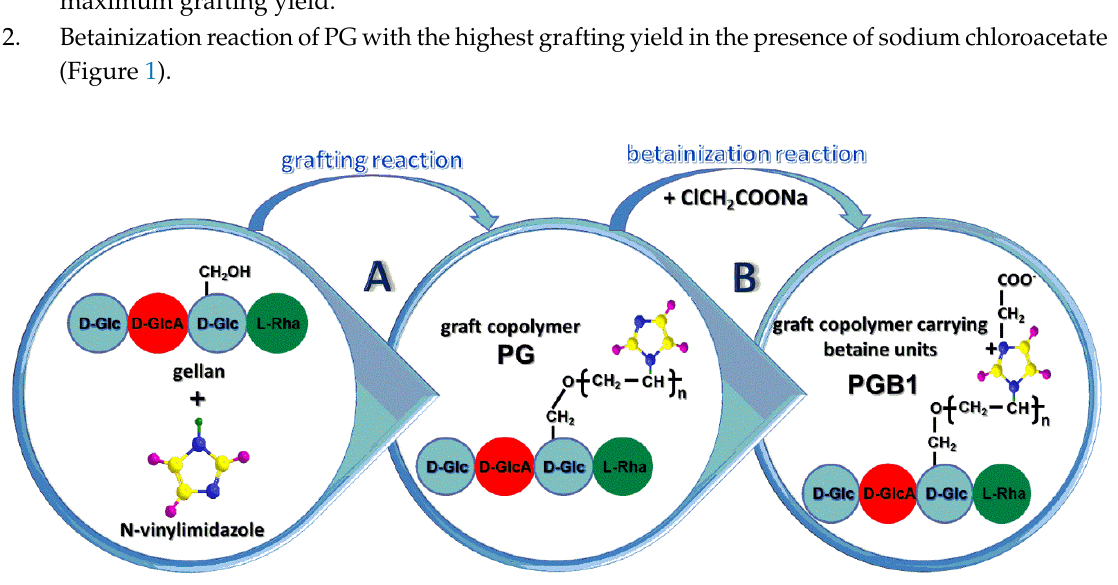
Figure 1. Graphical representation of the synthesis pathway of PG and grafted polymer carrying betaine units (PGB1) copolymers.